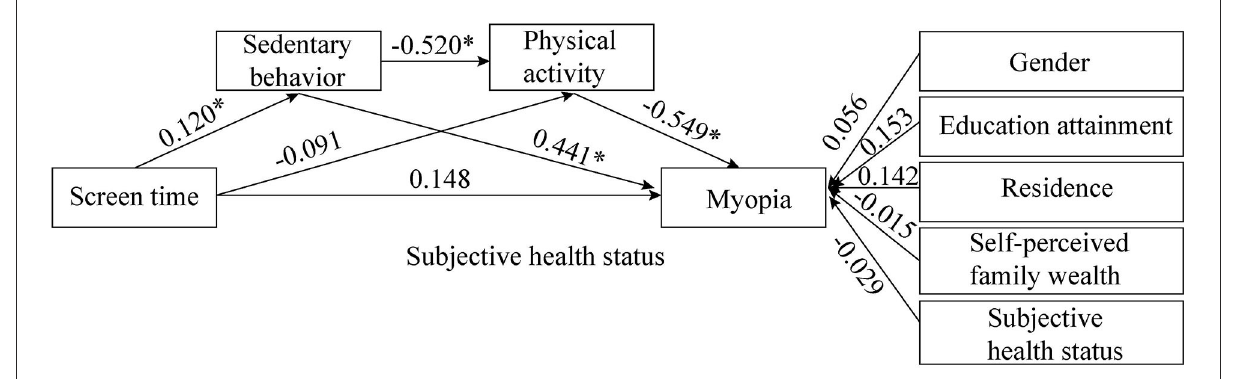
FIGURE3 The potential relationship between ST and Myopia ( X 2 = 135.289, p < 0.05; CFI = 0.944 > 0.90; TLI = 0.971 > 0.90; SRMR = 0.059 < 0.08), *significant at p <